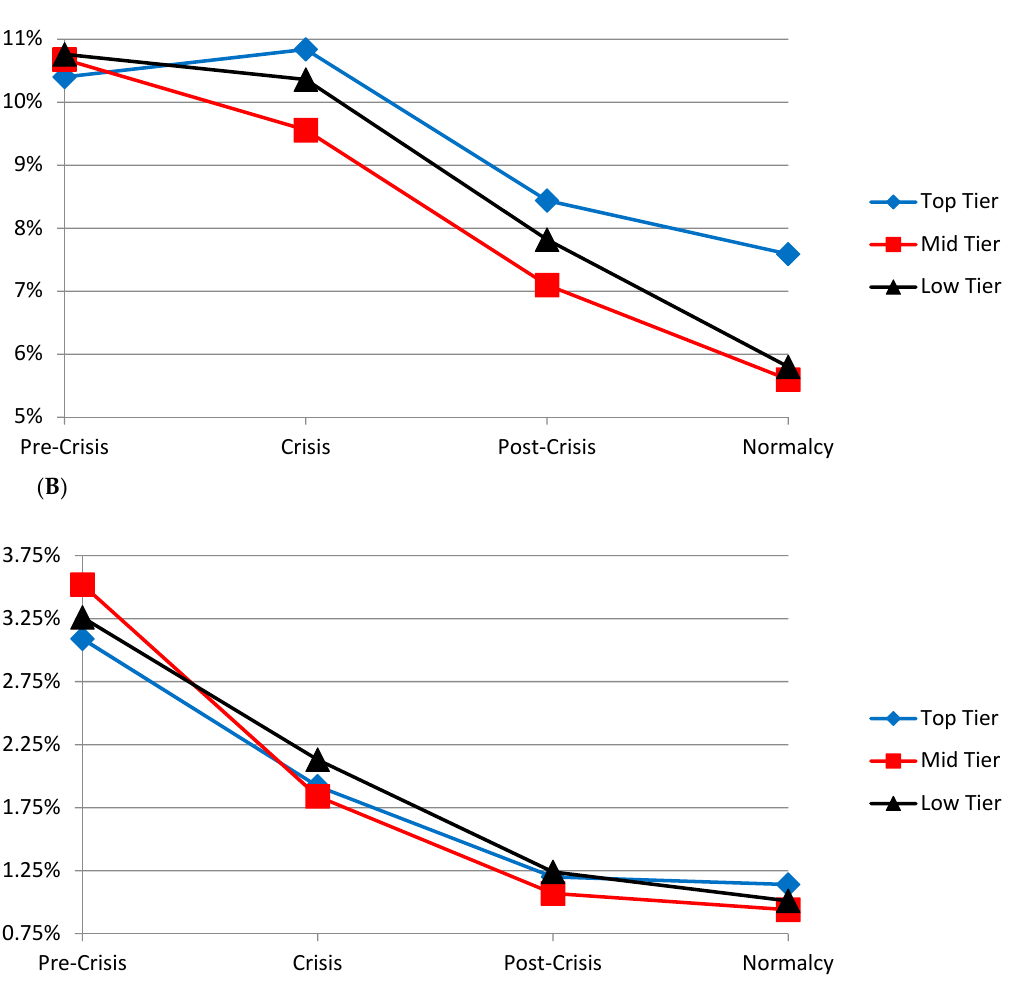
Figure 4. ( A ) Cost of Equity. ( B ) Weighted Average Cost of Capital (WACC). Notes: Top-Tier: